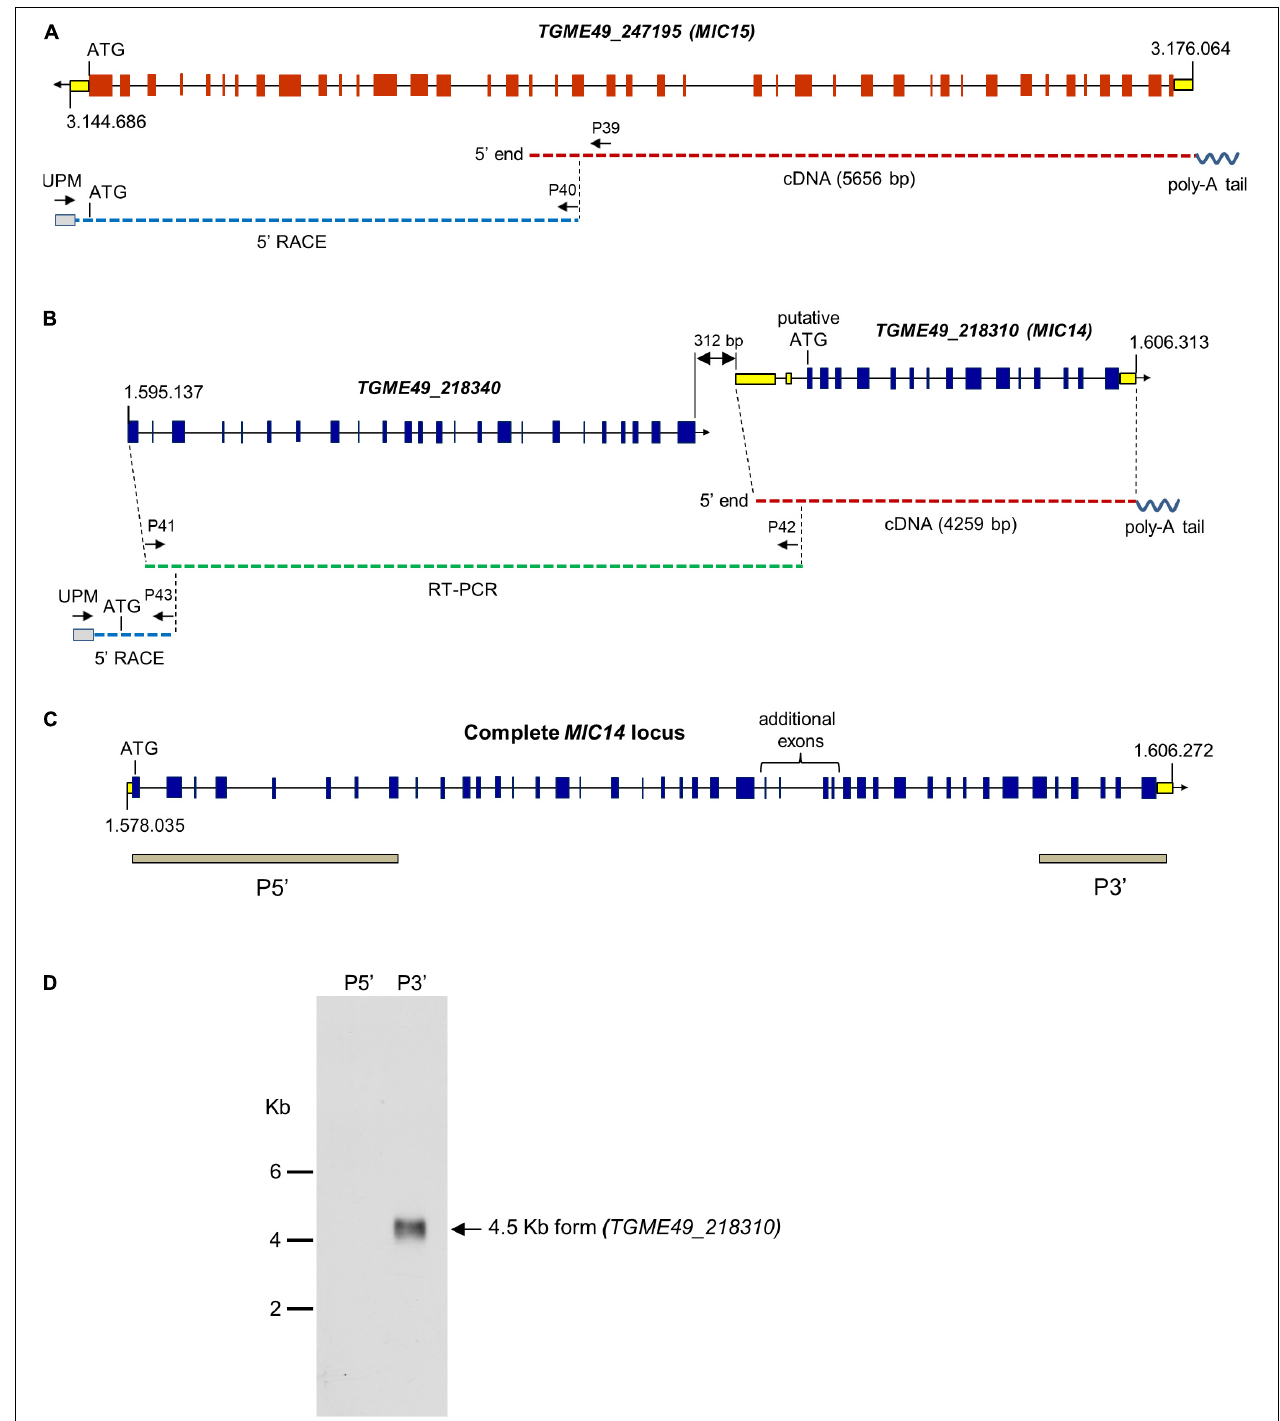
FIGURE 1 | Structure of the MIC14 and MIC15 genomic loci and analysis of MIC14 transcription. Schematic representation of the ToxoDB gene models of MIC15 (A) and MIC14 with the adjacent TGME49_218340 (B) . Predicted exons are shown as red ( MIC15 ) or blue ( MIC14 and TGME49_218340 ) boxes, untranslated regions as yellow boxes, intronic sequences as black lines. The numbers at the extremes of the gene models correspond to the nucleotidic positions on chromosome XII. Cloned cDNAs, RT-PCR amplicons or 5 (cid:48) RACE products are represented as red, green or blue dashed lines, respectively. The position of the primers used for transcript amplification is indicated by black arrows. (C) Structure of the complete MIC14 locus as deduced from the combined sequence resulting from the overlap between a library derived cDNA, RT-PCR, and 5 (cid:48) RACE products. The gray bars indicate the exons spanned by the two probes used for Northern blot hybridizations. (D) Northern blot analysis of tachyzoite total RNA with the MIC14 probes P5 (cid:48) and P3 (cid:48) . Exposure time, 96 h.